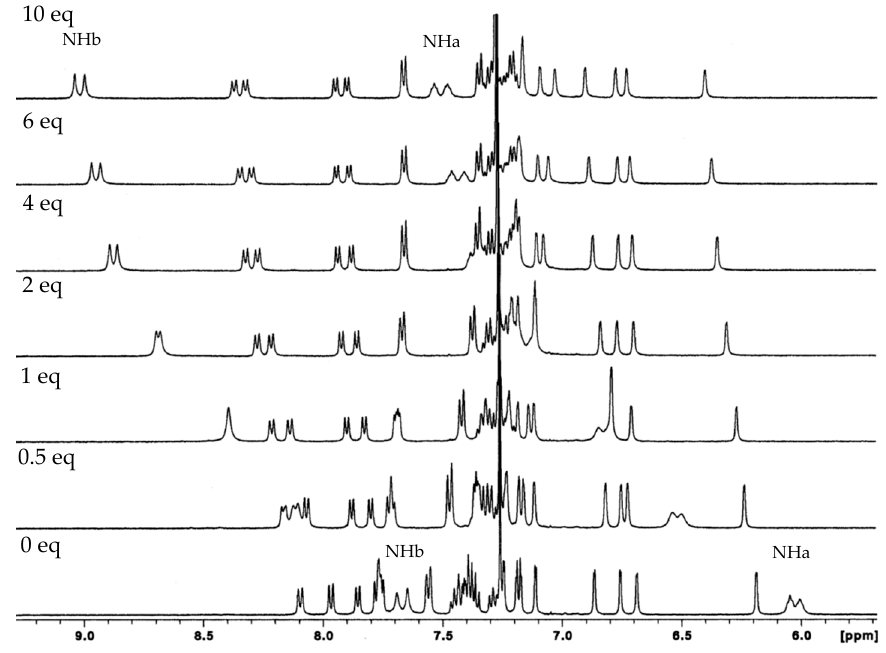
Figure 3. 1 H-NMR partial spectra (500 MHz, CDCl 3 , 25 ◦ C) of Naph-urea 5a with several equiv of TBA chloride.